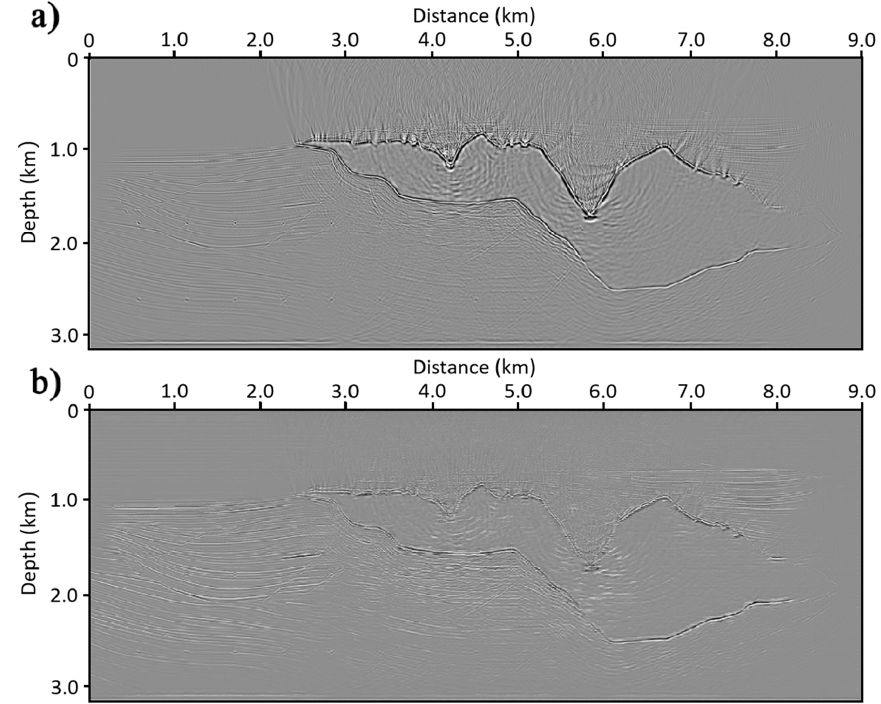
Figure 9. ( a ) The migration image of the Sigsbee model, and ( b ) the denoised Sigsbee model produced by the generator. As can be seen, the structure was undistorted, and the noise was largely suppressed, especially the noise between the surface and the rugged surface of the salt top.